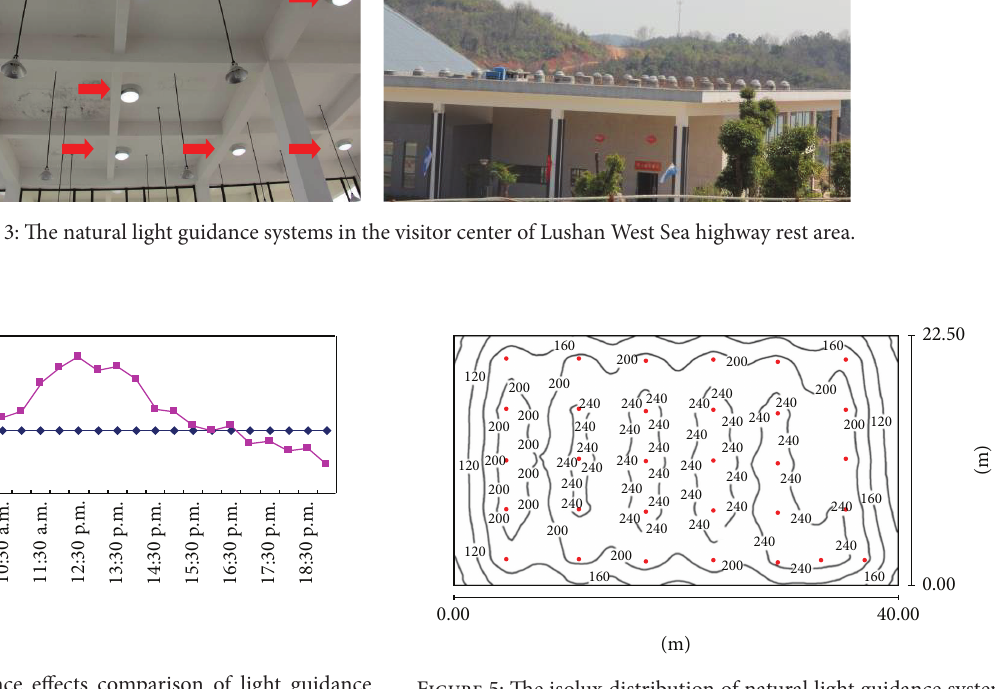
Figure 5: The isolux distribution of natural light guidance systems in the visitor